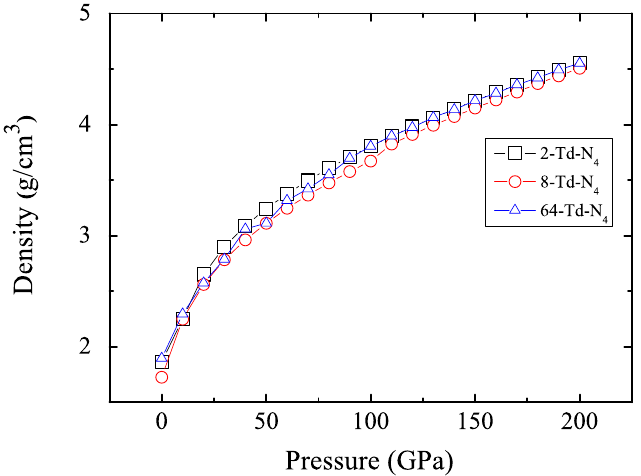
Figure 5. Density as a function of pressure for 2-Td-N 4 , 8-Td-N 4 , and 64-Td-N 4 . Black square represents 2-Td-N 4 , red circle represents 8-Td-N 4 , and blue triangle represents 64-Td-N 4